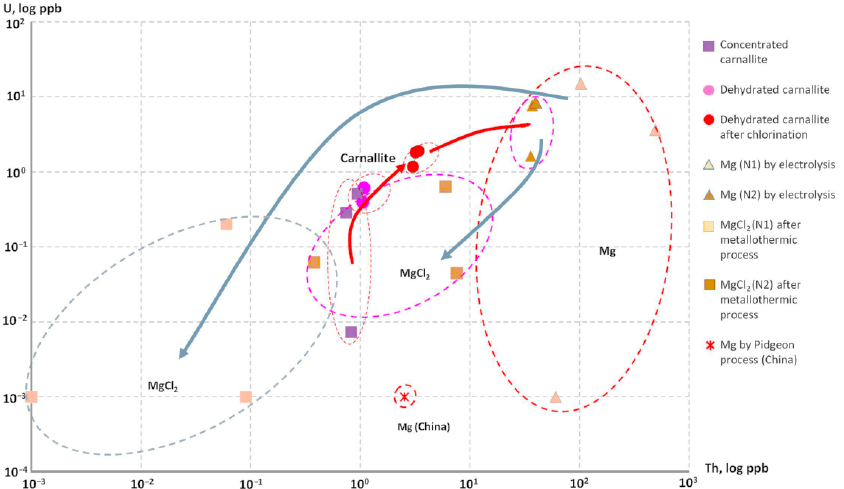
Figure 4. Distribution of U and Th in different samples of the materials used for Mg production via electrolysis process and Mg samples obtained by the various processes in comparison with MgCl 2 outputs from Kroll process (Table S2).